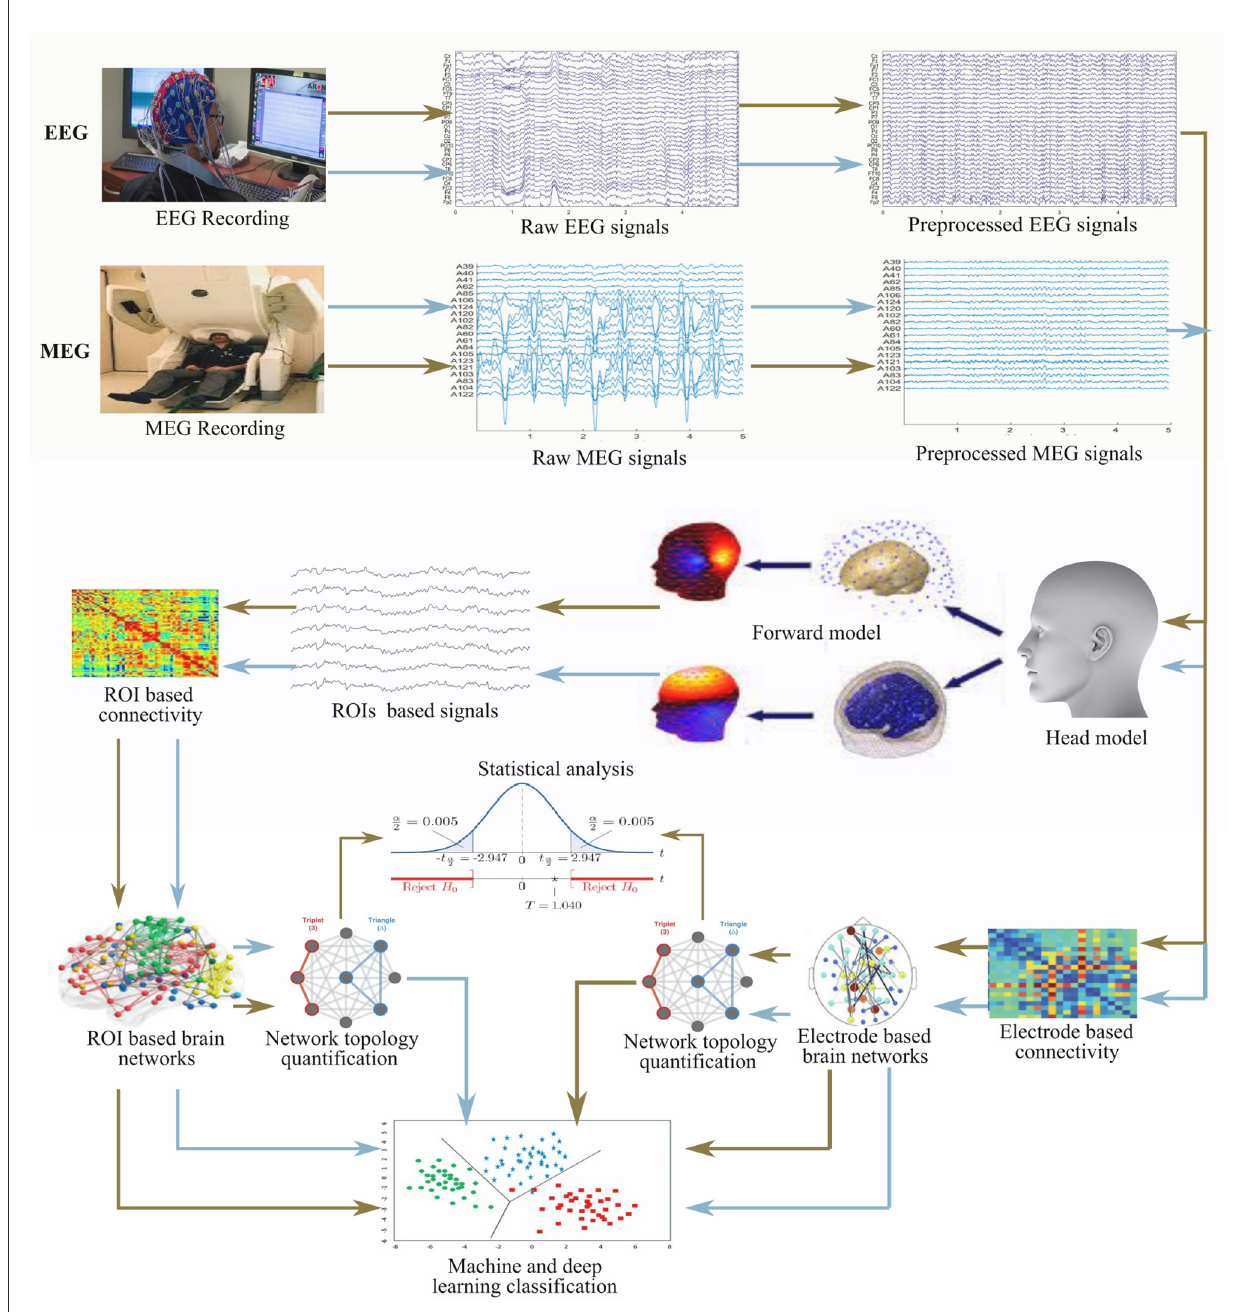
FIGURE2 General framework for the construction and analysis of brain network from electrophysiology signals (EEG and MEG).